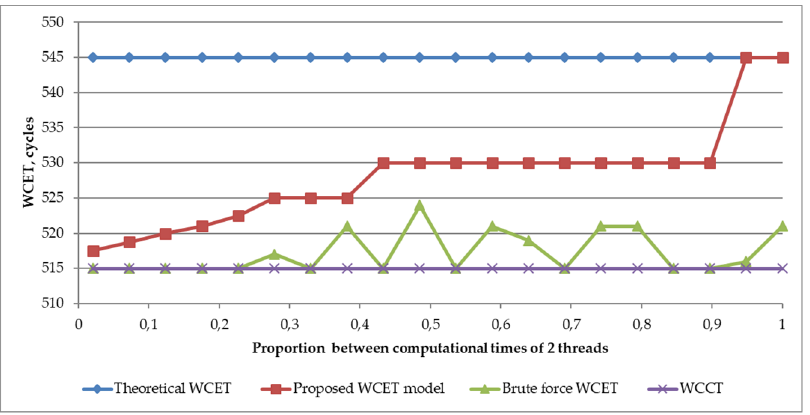
Figure 3. Extended results of Section 3.2 experiment results with two threads, illustrating the position of the proposed WCET model results in comparison to theoretical and realistic values.